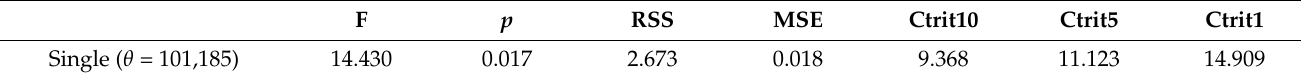
Table 4. The test results of the threshold